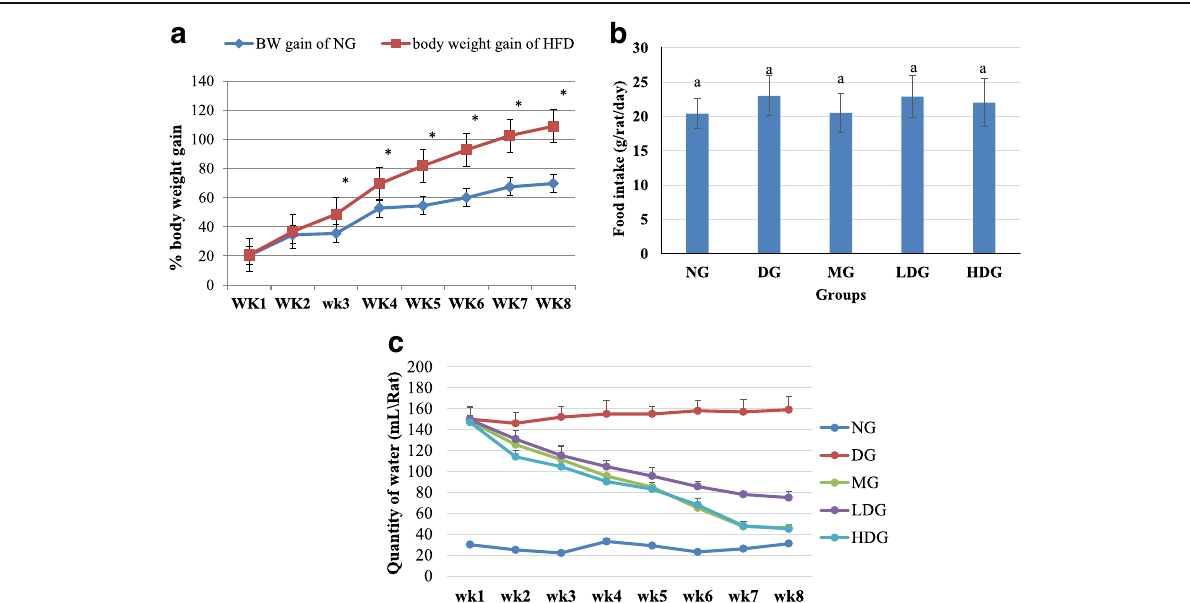
Fig. 2 a Body weight gain of normal diet group (NG) group and high fat diet (HFD) groups after 8 weeks of dietary manipulation, b Average of food intake c Average of drinking water consumption from baseline to the end of treatment by normal diet group (NG), diabetic group (DG),